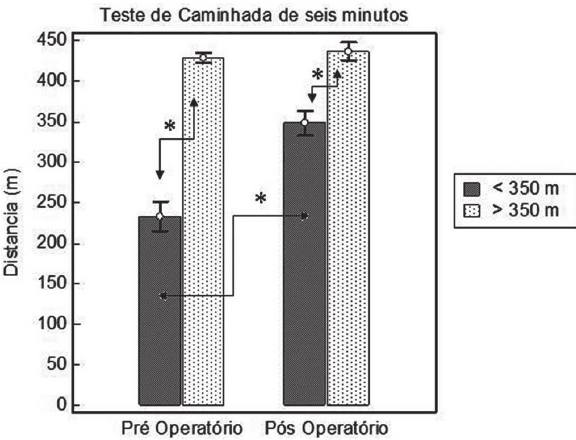
Fig. 1. Teste de caminhada de seis minutos. Distância caminhada em ambos os grupos, nas fases pré e pós-operatória. Valores expressos em média e erro padrão. Observa-se melhora na distância caminhada no pós-operatório apenas no grupo que caminhou <350 metros (233 ± 106 metros vs. 348 ± 87 metros, P <0,01) e o grupo >350 metros (428 ± 47 metros vs. 436 ± 78 metros, P= 0,40). *P<0,01